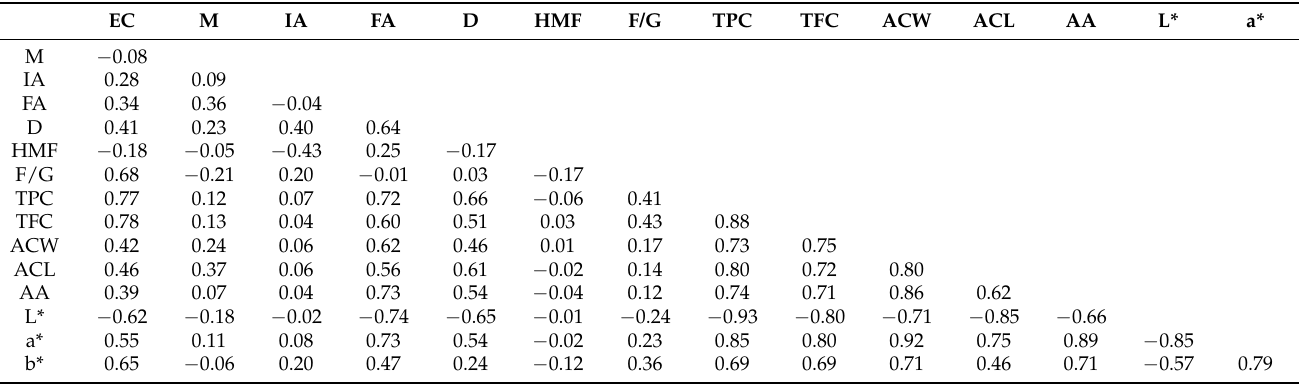
Table 3. Calculated correlations. EC—electrical conductivity, M—moisture, IA—invertase activity, FA—free acidity, D—diastase, HMF—hydroxymethylfurfural, F/G—fructose/glucose ratio, TPC—total polyphenol content, TFC—total flavonoids content, ACW—water-soluble antioxidants, ACL—lipid-soluble antioxidants, AA—amino acids, L*—lightness/darkness, a*—greenness/redness,